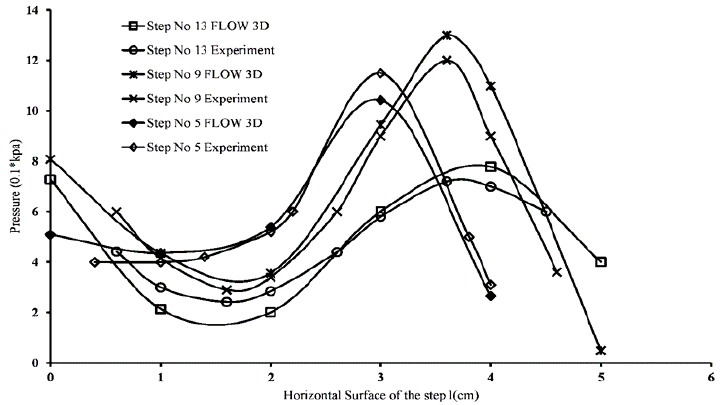
Figure 6. Pressure profiles comparison along the horizontal surface.